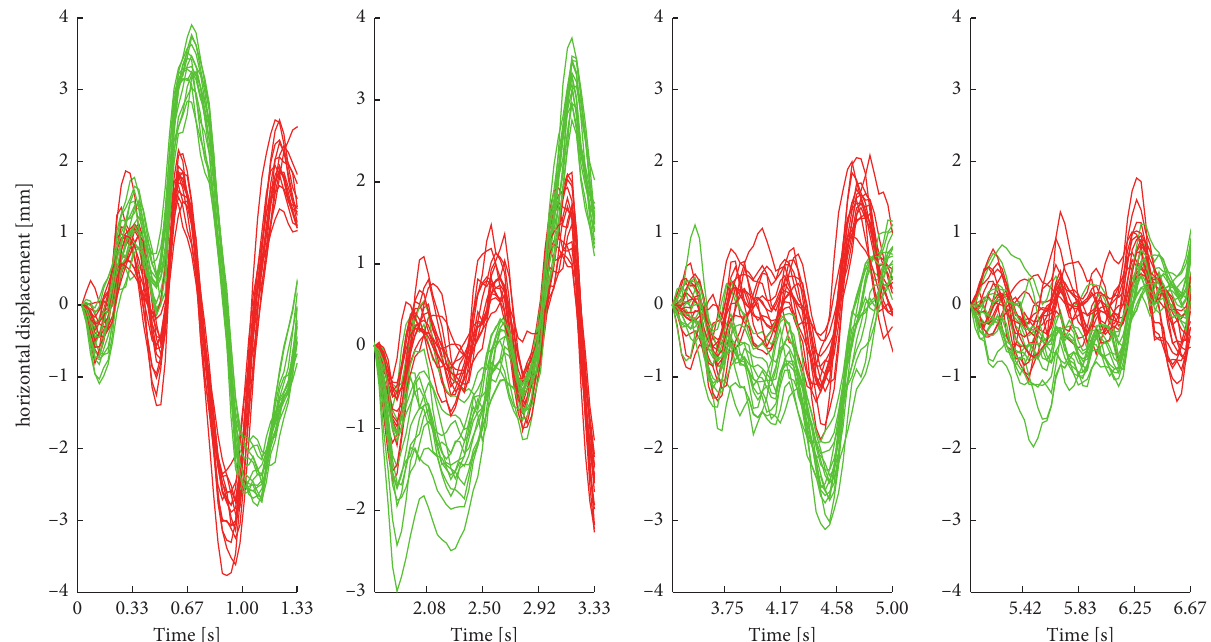
Figure 12: Four sections of the extracted displacement time histories ( α � 4; red: 15 output channels corresponding to the left building; green: 15 output channels corresponding to the right